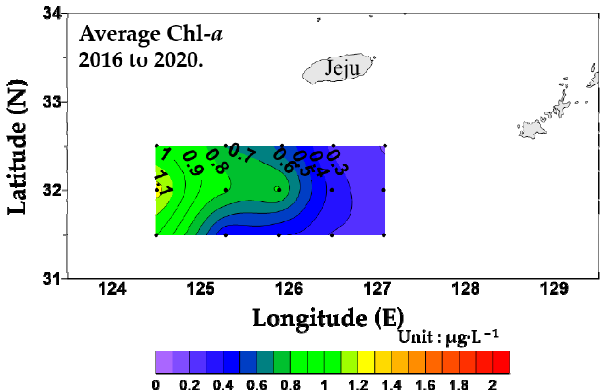
Figure 7. Spatial distributions of the average surface chl- a concentrations (µg·L − 1 ) in the northern East China Sea from 2016 to 2020.